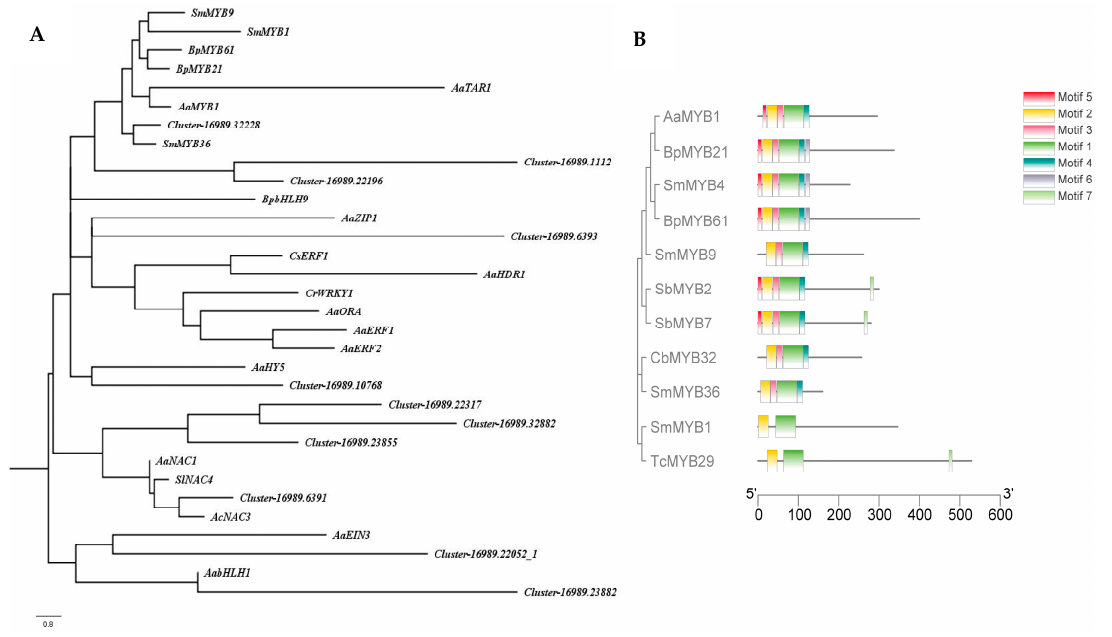
Figure 3. Phylogenetic analysis. Phylogenetic tree with TFs of C. blinii and other TFs have been reported involved in terpenoid metabolism within Artemis iaannua , Salvia miltiorrhiza , Scutellaria baicalensis , etc ( A ). Motif and phylogenetic tree with CbMYB32 and other MYB TFs. Different colors show different motifs ( B ).